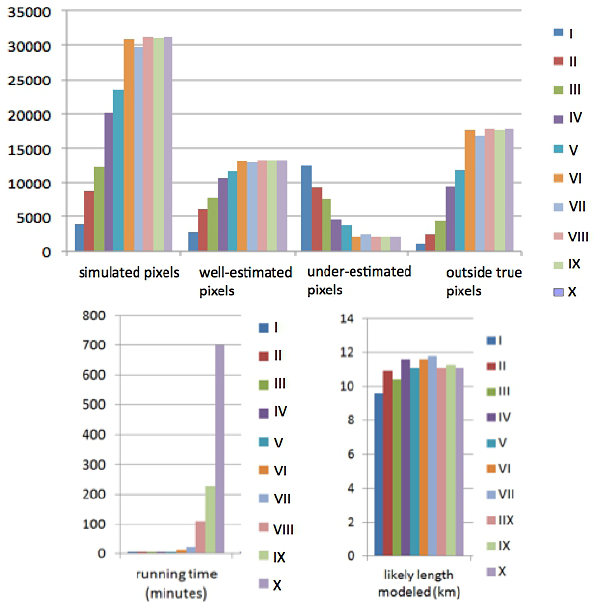
Figure 5. Sensitivity of the number of iterations for the simulation of the 2010 lava flow of Nyamulagira. (I to X simulations: 10, 50, 100, 500, 1000, 5000, 10000, 50000, 100000, and 500000 itera- tions, respectively).